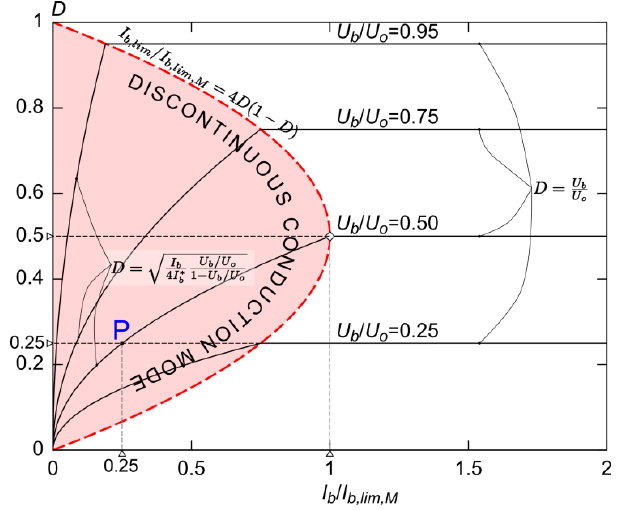
Figure 12. Layout 1 charge operation: D as a function of I b / I b,lim,M for different U o / U b